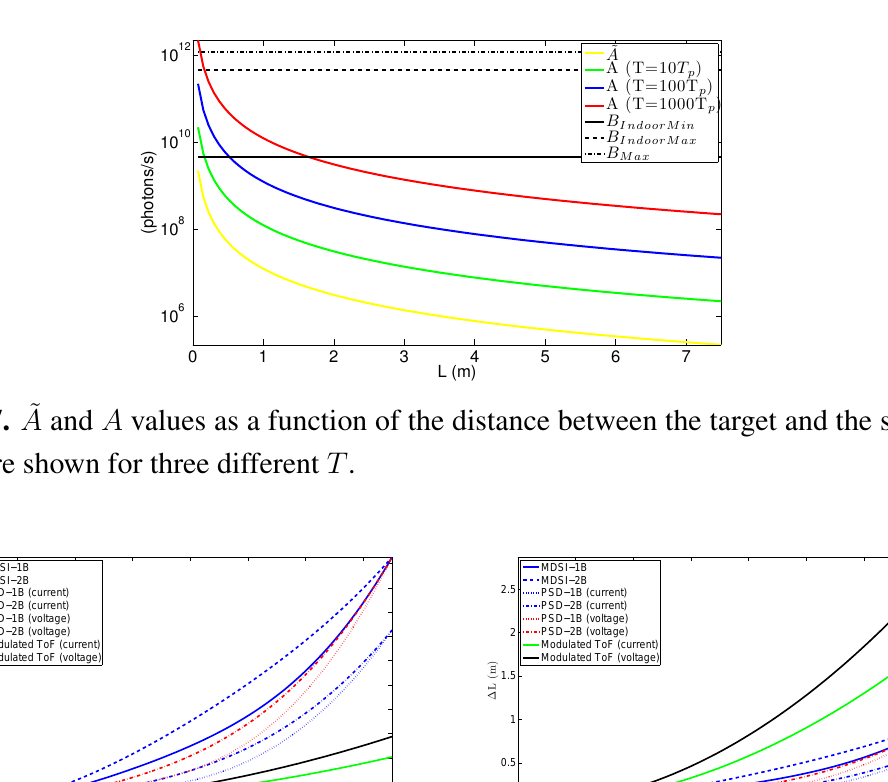
); ( b ) T = 50 µ s (1000 T p p